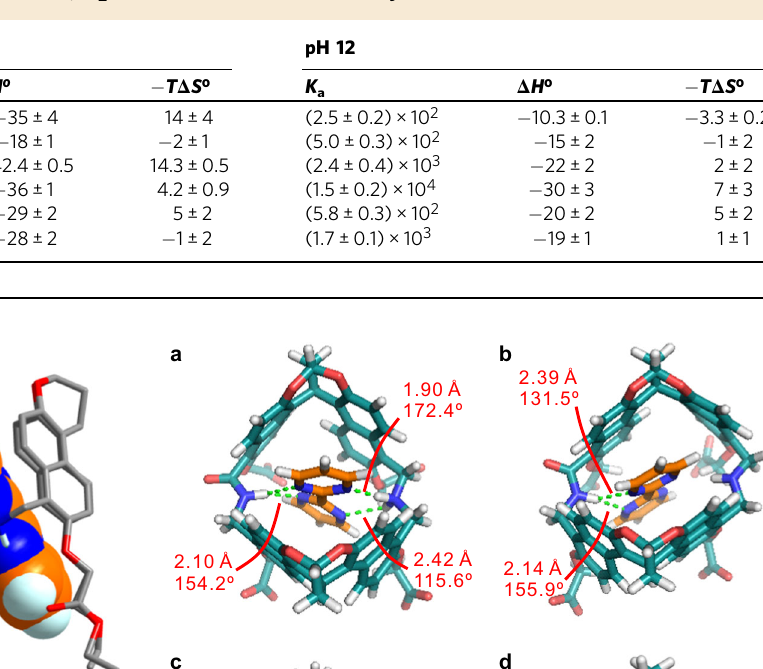
Table 2 Association constants ( K a , M − 1 ) and thermodynamic parameters ( Δ H o and − T Δ S o , kJ mol − 1 ) of naphthotubes 5a and 5b